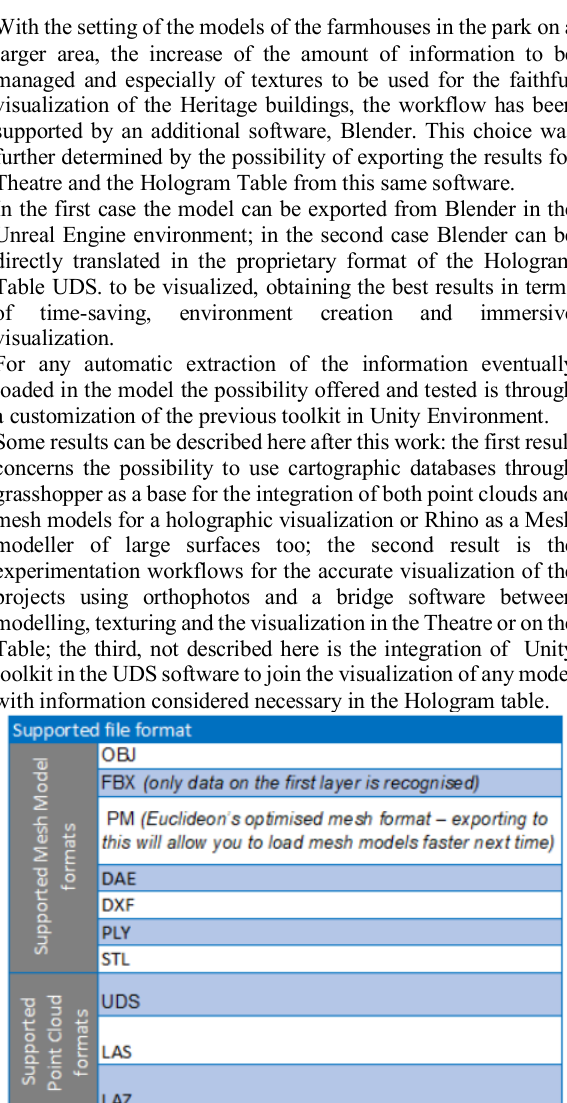
Figure 10. Settings of the projectors in the Immersive Theater